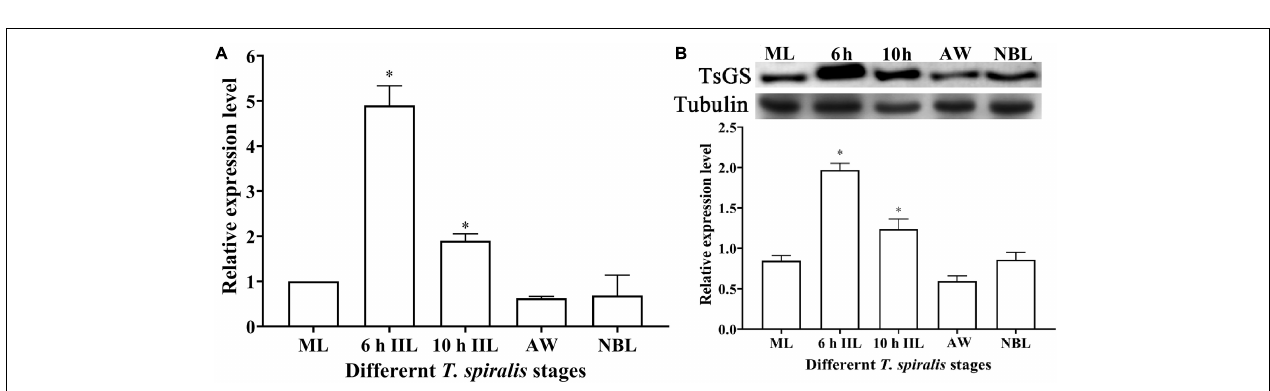
FIGURE 4 | Transcription and expression of TsGS in various Trichinella spiralis stages. (A) qPCR analysis of TsGS transcription in various T. spiralis stages. (B) Western blotting of TsGS expression in somatic proteins of muscle larvae (ML), 6-h intestinal infectious larvae (IIL), 10-h IIL, 3-day adult worms (AW), and newborn larvae (NBL). The TsGS expression level in IIL stages was significantly higher than in other stages. ∗ P < 0.05 compared with the ML group.